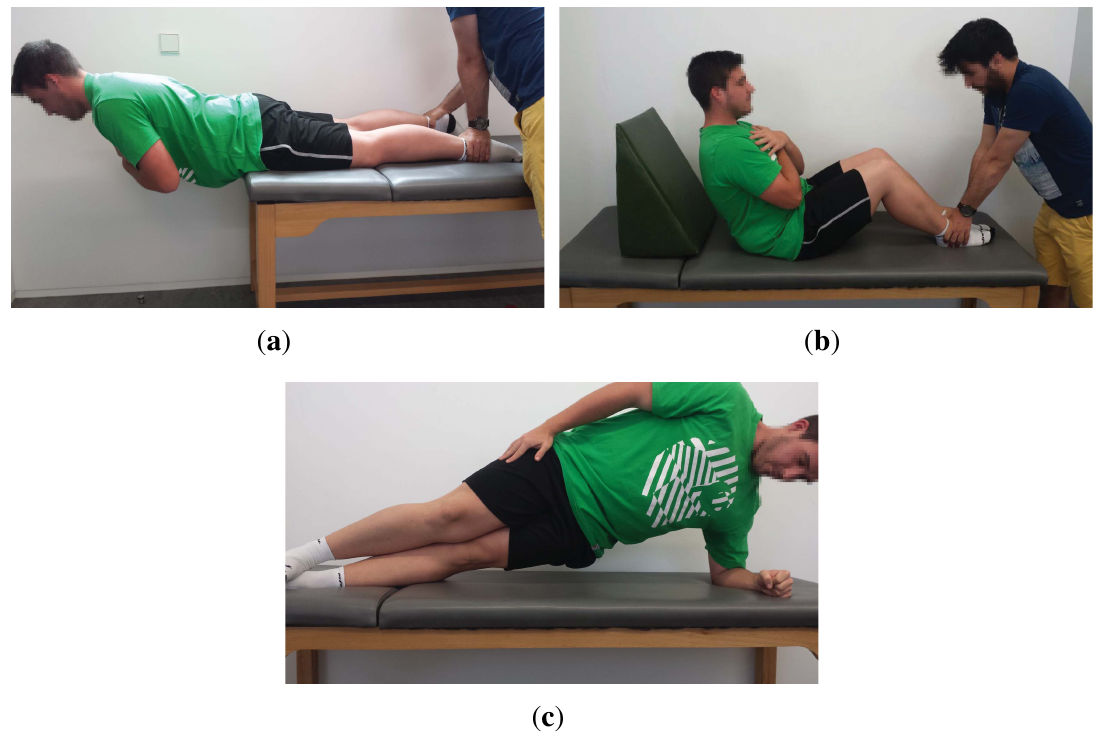
Figure 2. Trunk endurance assessment tests: ( a ) STEET; ( b ) TCSET; and ( c )